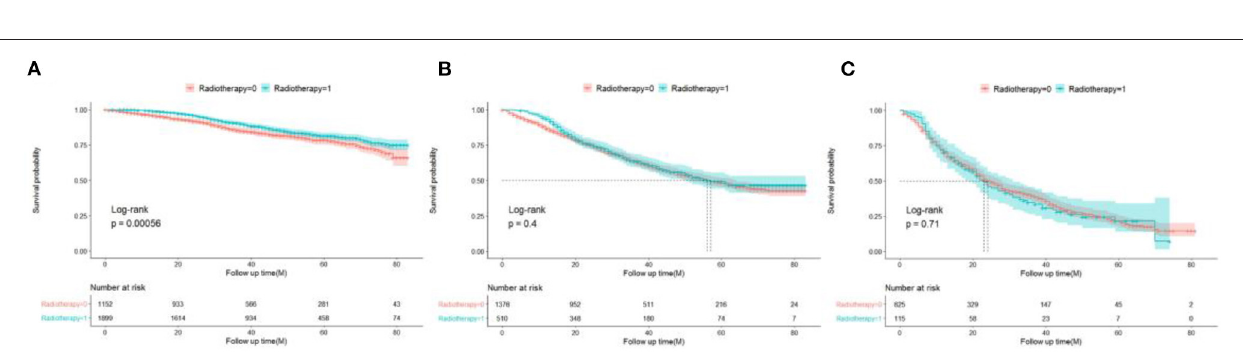
FIGURE 6 | Kaplan–Meier curves of OS for patients in the low-, intermediate-, and high-risk groups. (A) all cohorts (B) training cohort (C) validation cohort.